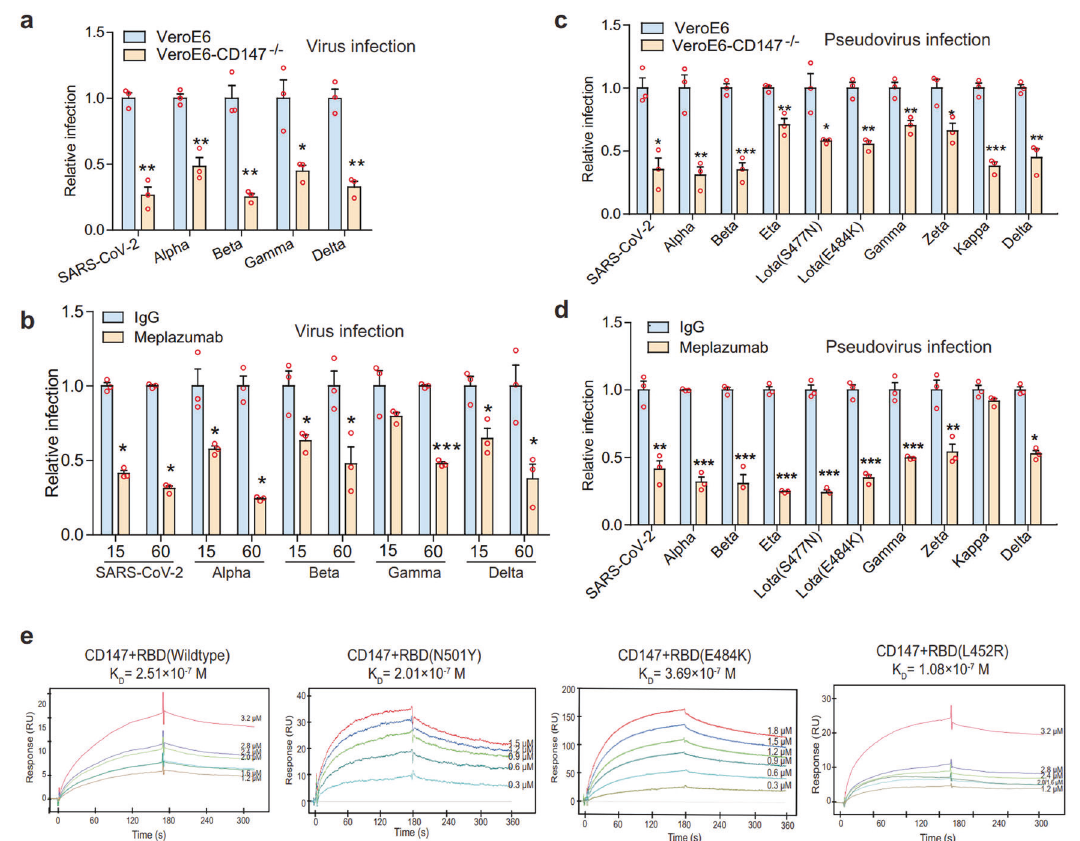
Fig. 1 CD147 knockout and anti-CD147 antibody exhibit universal inhibition against SARS-CoV-2 and variants. a SARS-CoV-2 and its four variants — alpha, beta, gamma, and delta infected VeroE6 cells or CD147 − / − VeroE6 cells for 48 h, and RNA was collected for viral RNA detection by Taqman RT-qPCR. Data are normalized to the infectivity in wild-type VeroE6 cells ( n = 3, two-tailed student t test, * p < 0.05, ** p < 0.01). b Meplazumab inhibiting the infection of VeroE6 cells by SARS-CoV-2 and its four variants. Data are normalized to the infectivity in IgG group ( n = 3, Two-tailed student t test, * p < 0.05, *** p < 0.001). c Viral infection ef fi ciency was detected by luciferase reporter assay. VeroE6 cells and CD147 − / − VeroE6 cells were infected with the SARS-CoV-2 and nine mutant strains of SARS-CoV-2 pseudoviruses. Data are normalized to the infectivity in wild-type VeroE6 cells ( n = 3, Two-tailed student t test, * p < 0.05, ** p < 0.01, *** p < 0.001). d Meplazumab (60 μ g/ml) inhibiting the infection of VeroE6 cells by SARS-CoV-2 and nine mutant strains of SARS-CoV-2 pseudoviruses. Data are normalized to the infectivity in IgG group ( n = 3, Two-tailed student t test, * p < 0.05, ** p < 0.01, *** p < 0.001). e The interaction of CD147 and RBD mu t ants detected by SPR